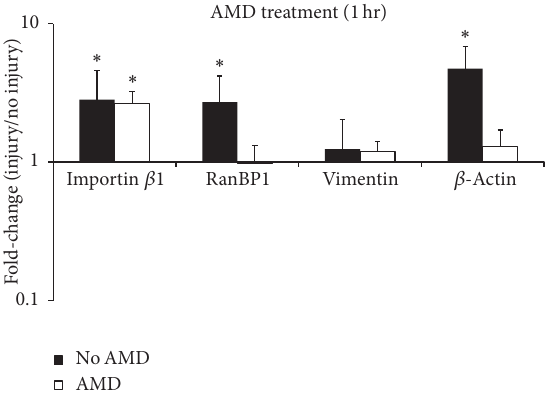
Figure 3: Inhibition of transcription results in differential axonal transcriptional changes. Real-time RT-PCR was used to measure levels of axonal mRNA in injured hippocampal axons after inhibit- ing transcription with AMD. All values are displayed relative to uninjured controls. Results indicate persistent elevation of importin 𝛽 1 mRNA levels after transcriptional inhibition but not RanBP1, vimentin, and 𝛽 -actin. Black bars (previously graphed in Figure 2, 1hr) indicate untreated axons and are included for clarity of comparison. Error bars represent standard deviations. ∗ indicates significant difference of AMD treated and untreated cells from their corresponding controls ( p < 0.05) based on pairwise fixed allocation test. 𝑁 = 3 for all groups.